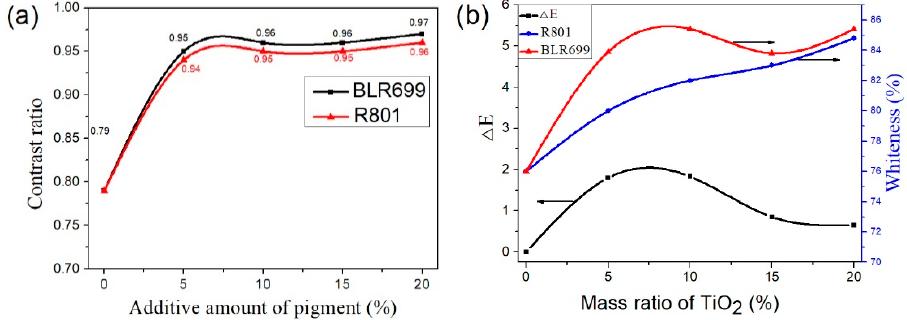
Figure 7. Properties of the two exterior paints respectively containing R-801 and BLR-699. ( a ) Contrast ratio of paint; ( b ) Whiteness and chromatic aberration of paint.